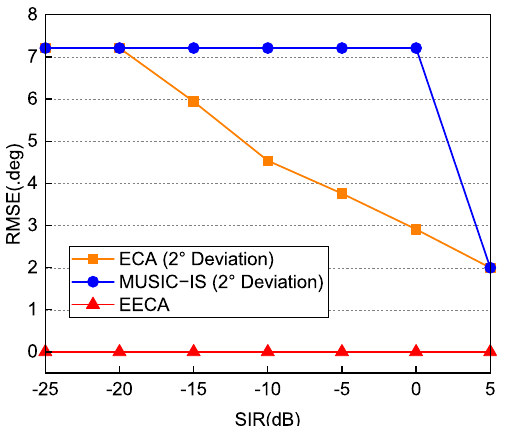
Figure 4. Comparison of RMSE versus SIR curves among the ECA (2 ◦ deviation), MUSIC-IS (2 ◦ deviation), and EECA in Scenario